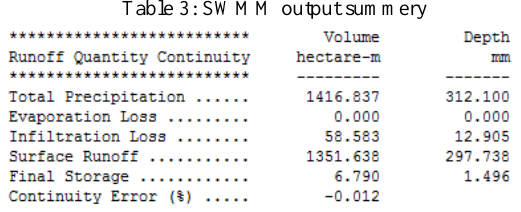
Table 3: SWMM output